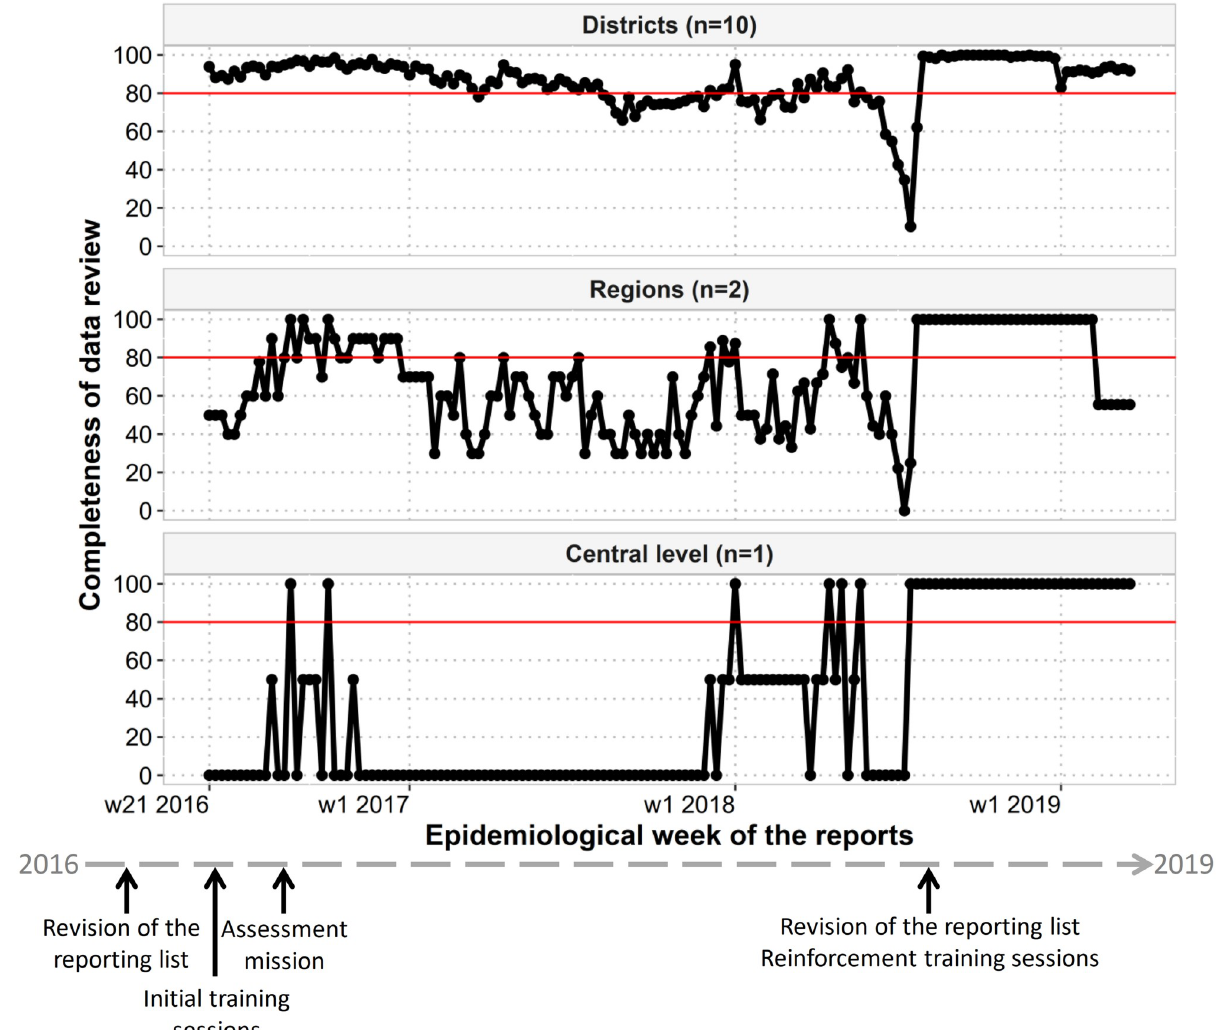
Fig 4. Evolution of completeness of data review from week 21 2016 to week 12 2019 by level. The drop on week 30 of 2018 was linked to the update of the system to accommodate the new list of diseases to be